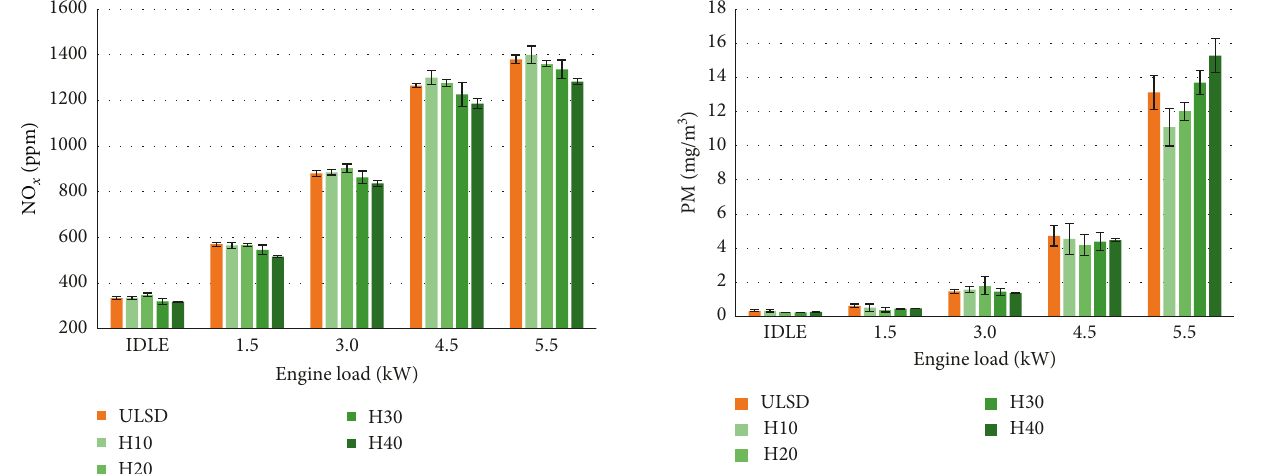
Figure 10: Nitrogen oxides emissions for ULSD and HUCO blends for all